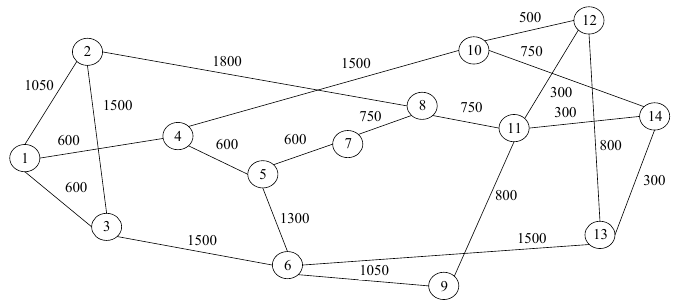
Figure 8. Simulated NSFNET network topology.